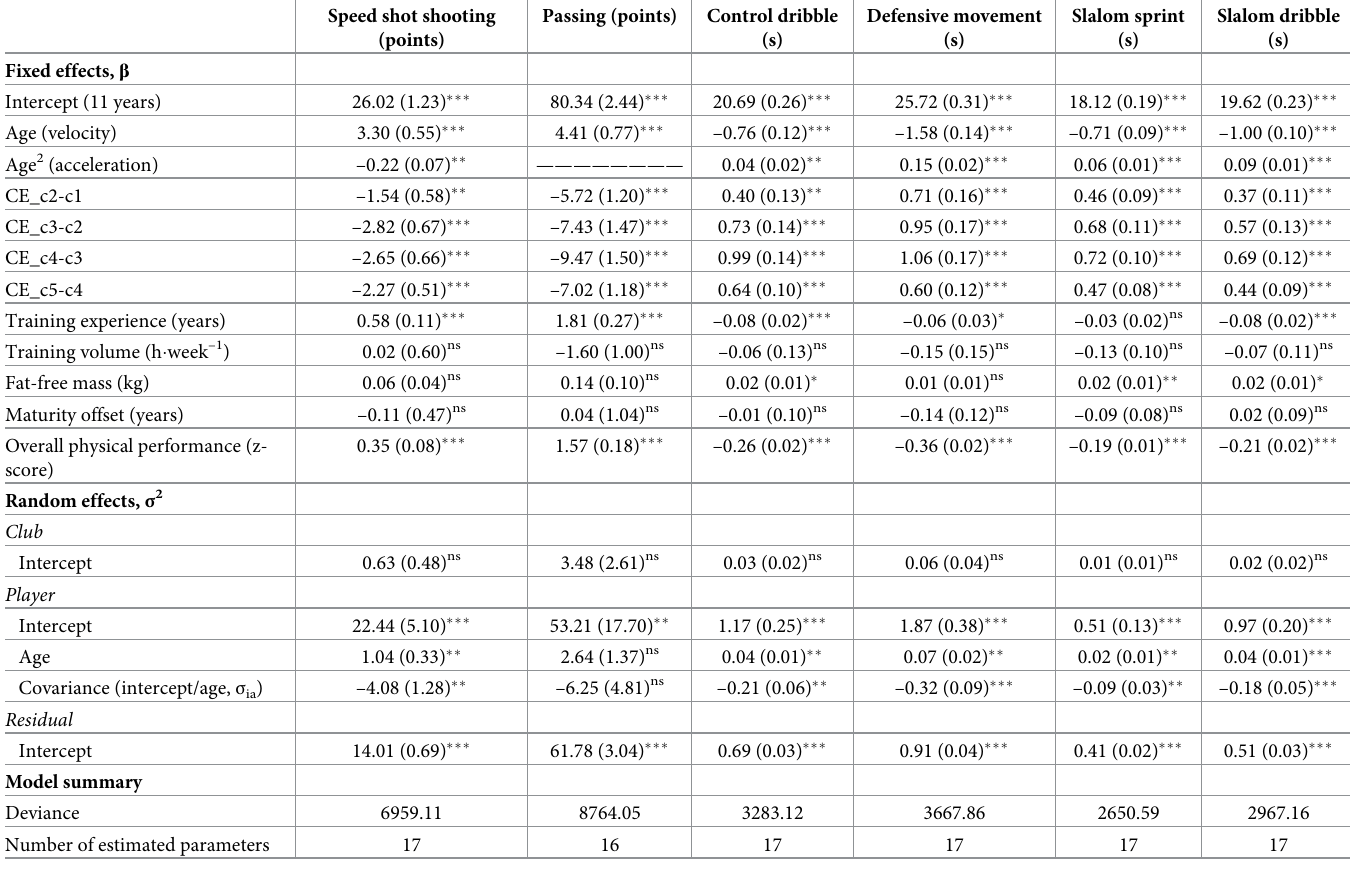
Table 3. Multilevel regression models for technical skills development: Parameter estimates (standard-errors) for fixed and random